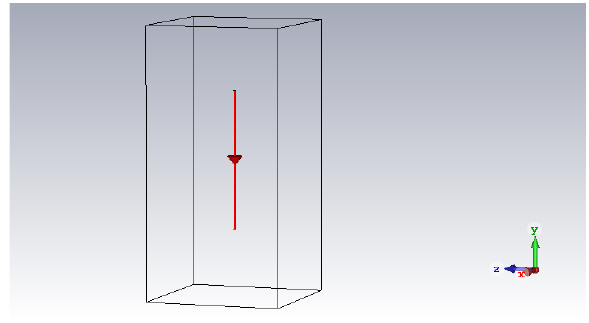
Figure 4, A half-wave dipole antenna with its bounding box in CST